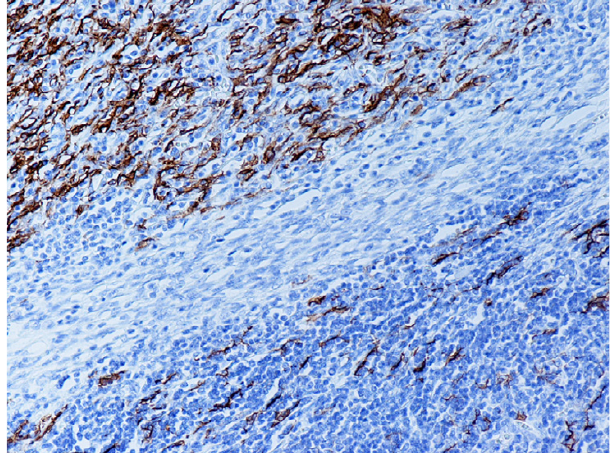
Figure 6 (B-SA, anti-CD20, × 200): Type AB thymoma. Neoplastic epithelial cells in type A and B components express CD20.